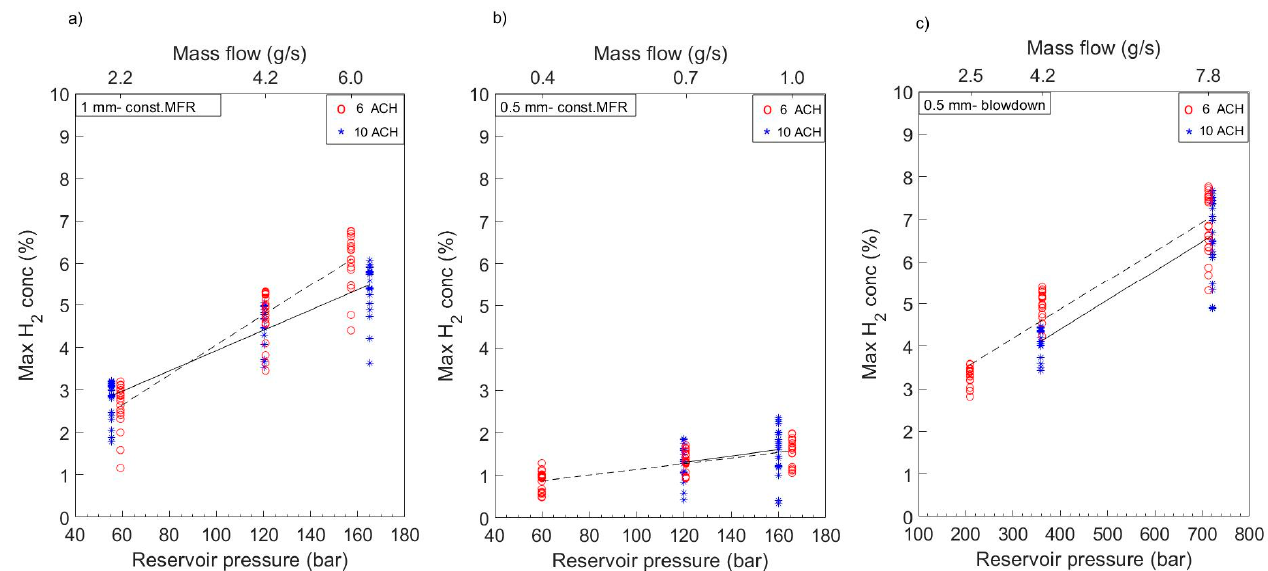
Figure 5. Maximum hydrogen concentration resulted with 6 ACH (dash line) and 10 ACH (solid line) during constant mass flow releases ( a ) through 1 mm diameter nozzle, ( b ) 0.5 mm diameter nozzle, and ( c ) blowdown mass flow releases through 0.5 mm nozzle. Maximum concentrations at each sensor during 10 ACH (blue star) and 6 ACH (red circle).